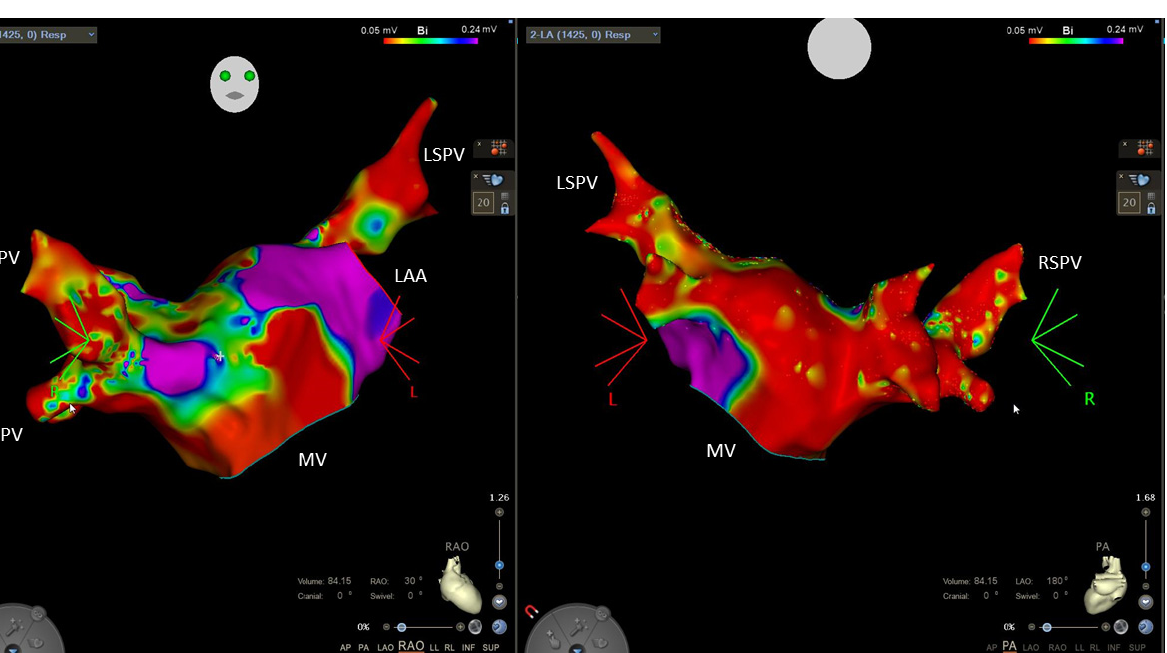
Figure 2. Electroanatomical mapping of left atrium in a patient with β -thalassemia and atrial fibrillation. Panel on the left: right anterior oblique view. Panel on the right: posteroanterior view. Colors indicate electrical potentials. The red color indicates regions with low voltages (<0.05 mV) while purple color indicates normal voltages (>0.24 mV). Of note, a large part of the left atrium shows low electrical potentials, consistent with fibrosis, while normal voltages, identifying healthy muscular walls represent only a small, patchy part of the atrium. MV: mitral valve; LAA: left atrial appendage; LSPV: left superior pulmonary vein; RSPV: right superior pulmonary vein; RIPV: right inferior pulmonary vein.